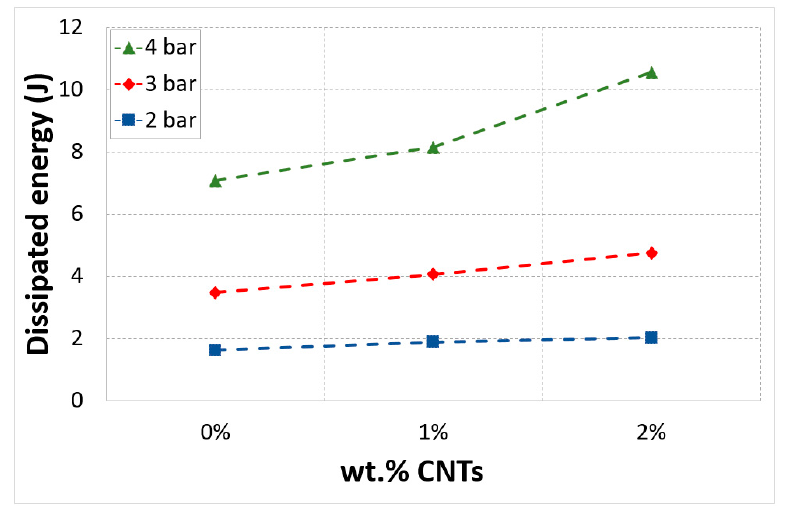
Figure 11. Dissipated energy vs CNTs mass fractions.